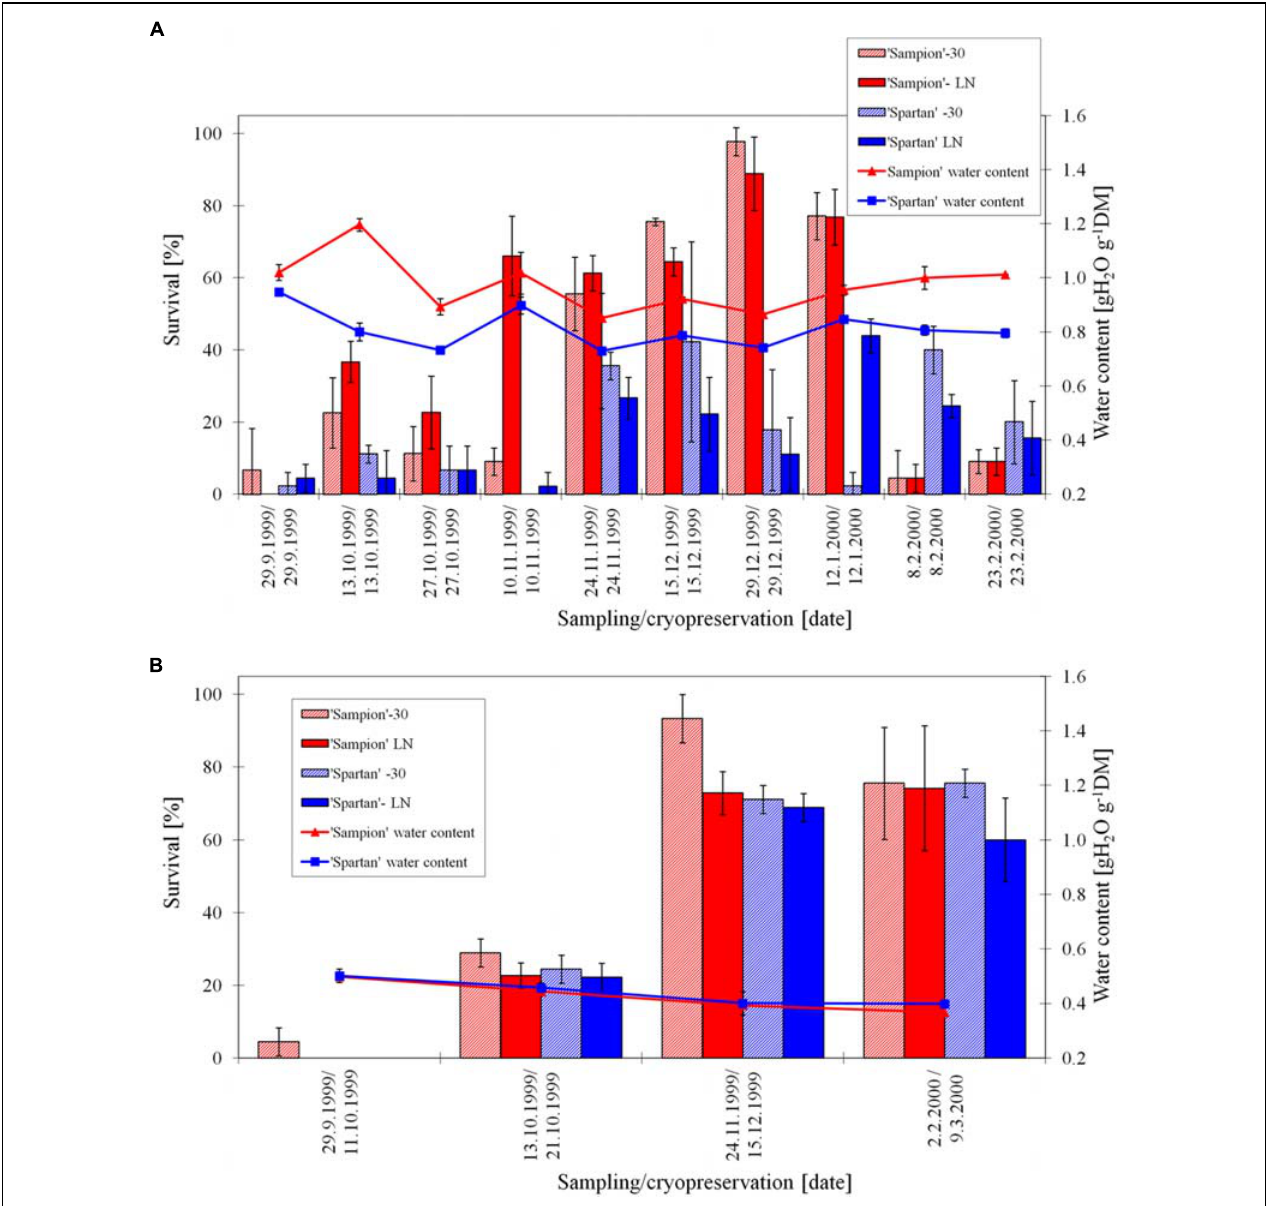
FIGURE 5 | Survival and water content of non-dehydrated (A) and dehydrated (B) vegetative buds of apple cultivars ‘Sampion’ and ‘Spartan’ (B) in the seasons of 1999/2000. ND was cryopreserved immediately after sampling from the orchard. D variant was cryopreserved after frost dehydration of at least 1 week at –4 ◦ C. Survival was evaluated after the first step of cryopreservation protocol at –30 ◦ C (–30), and after the second step, reaching the LN temperature. Survival was tested by examination of oxidative browning of tissues on the longitudinal cut of the bud. Water content was measured immediately before cryopreservation procedure. Bars indicate SD ( p <